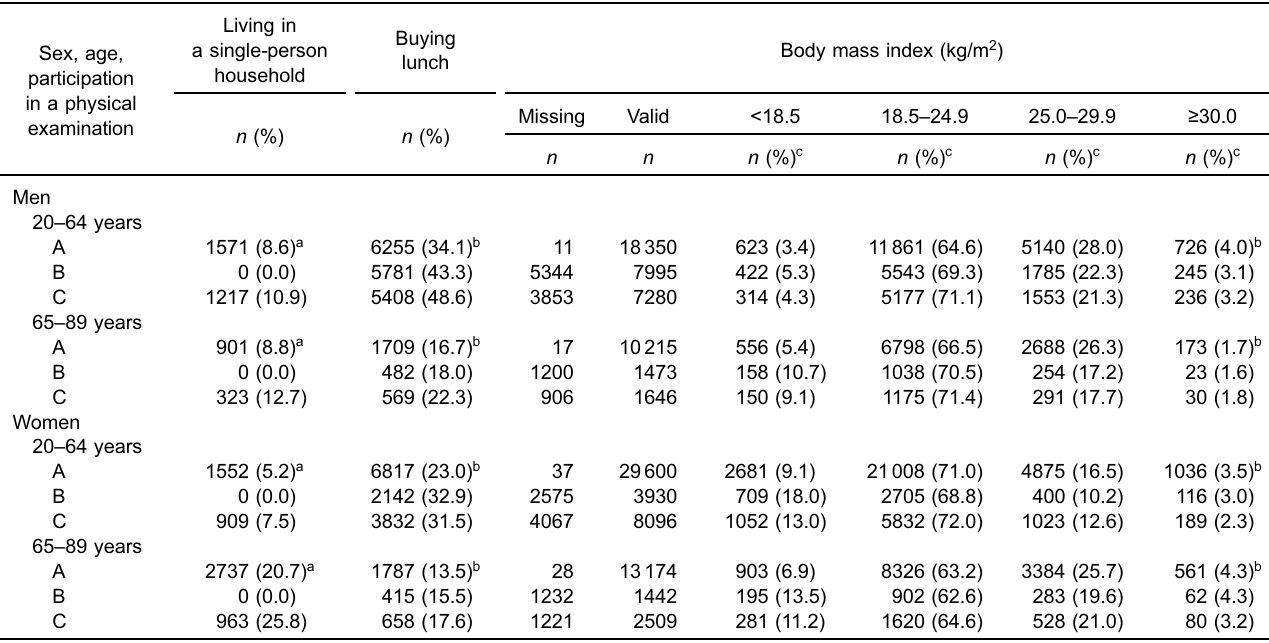
Table 3. Characteristics of study subjects by status of participation in a physical examination, sex, and age group, from pooled data of surveys in 1997 – 2011